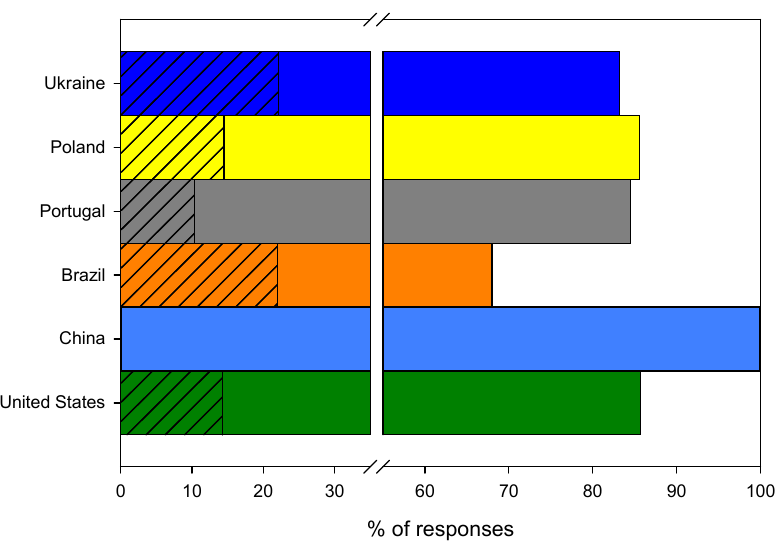
Figure 8. The distribution of answers of “not able to pay extra” (coarse bar) and “below 10%” (full bar) for the question: How much more would you be able to pay for a product packed in bioplastic? The data are given in a stacked form.